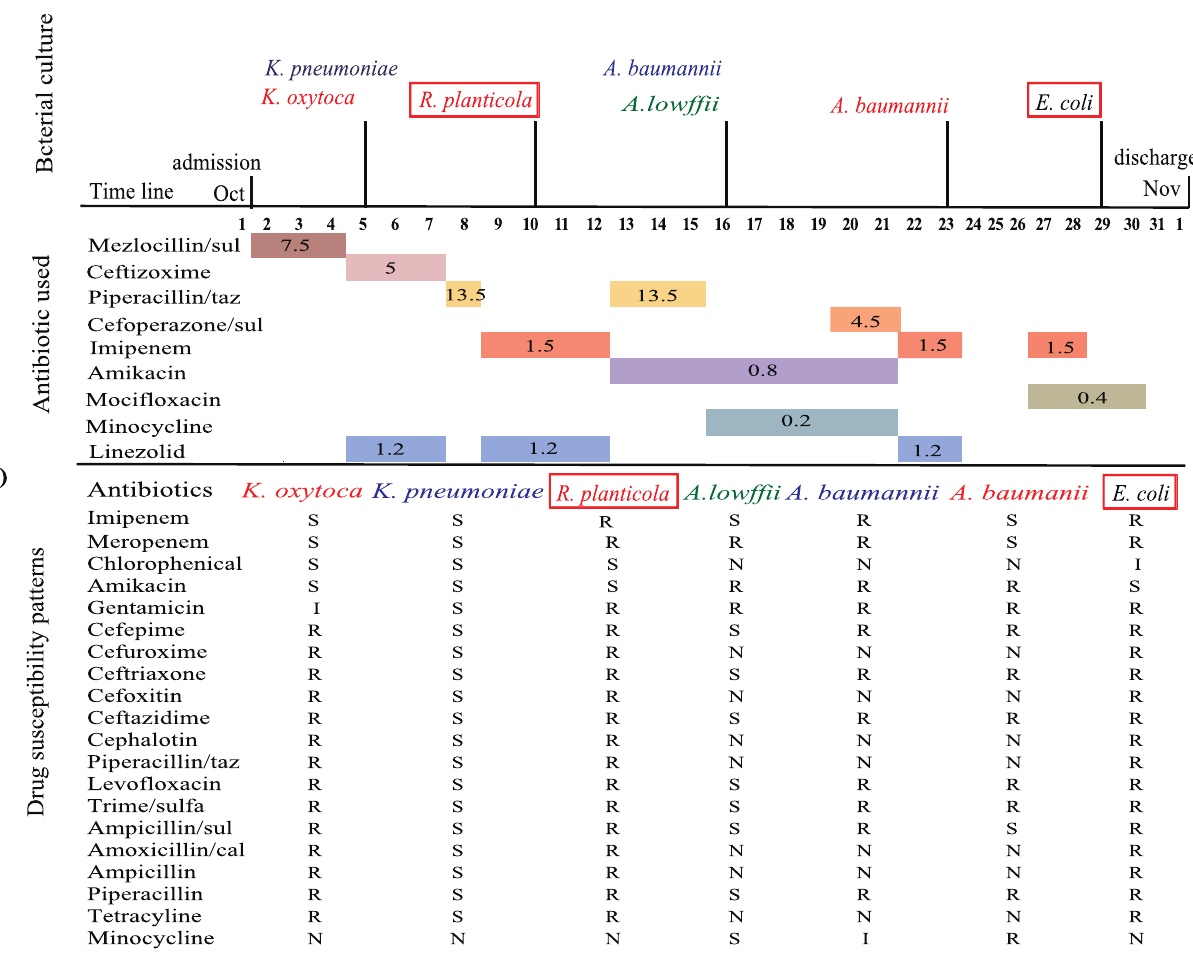
Figure 1. Time line of antibiotics treatment, microbiological investigation and isolation of NDM-1 positive R.planticola and E.coli . ( a ): Time line of events during the 34-day hospitalization of the patient. Bacterial species isolated at a particular time point are shown above the time line while antibiotics used and their durations are marked below the time line. The sources of strains are colour coded: red, from blood; blue, from sputum; green: from urine; black, from feces. Red boxed: NDM-1 positive bacteria. The number in bracket after a given antibiotic is dosage of the antibiotic used (g/day). ( b ): Antibiotics resistance profiles of bacteria isolated. Interpretation of results: S, susceptible; I, intermediate; R, resistant; N, not